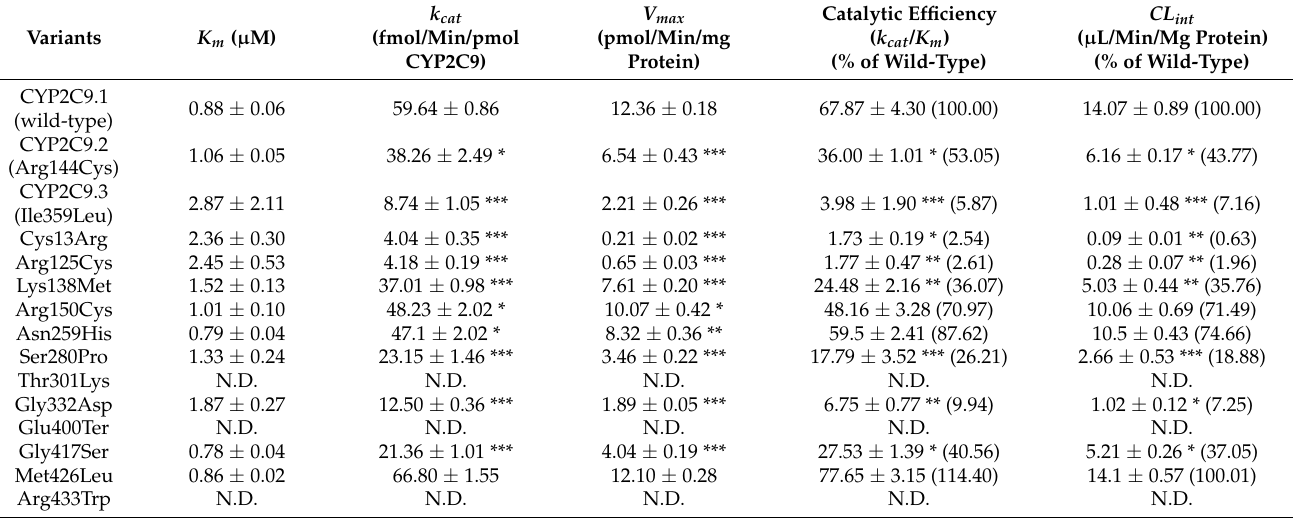
Table 3. Kinetic parameters of ( S )-warfarin 7-hydroxylation by microsomes from 293FT cells expressing wild-type and variant CYP2C9 proteins.